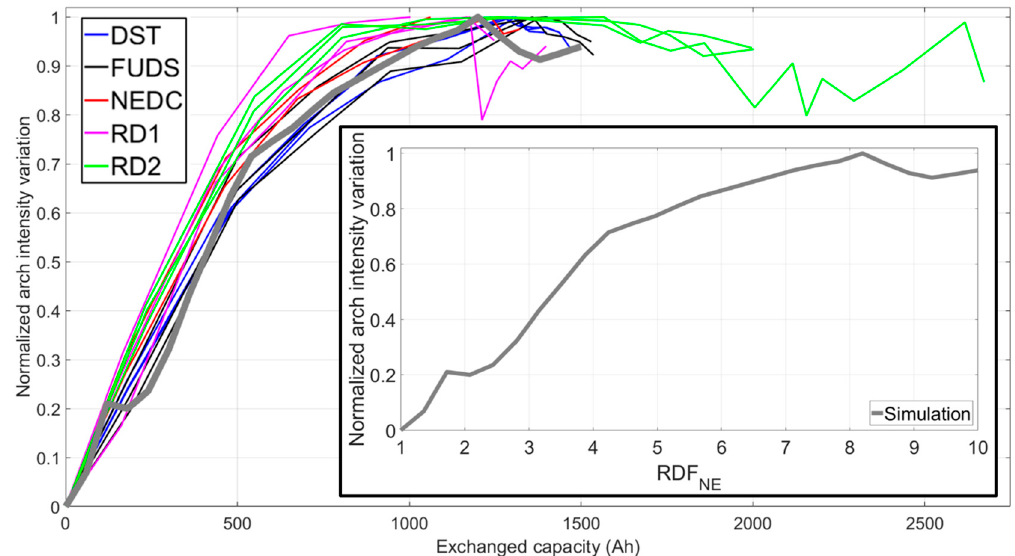
Figure 6. Evolution of the arch intensity during the initial stage of degradation for all the cells tested vs. the exchanged capacity. The inset is a plot of the simulated intensity variation vs. rate degradation factor at the negative electrode (RDF NE ).